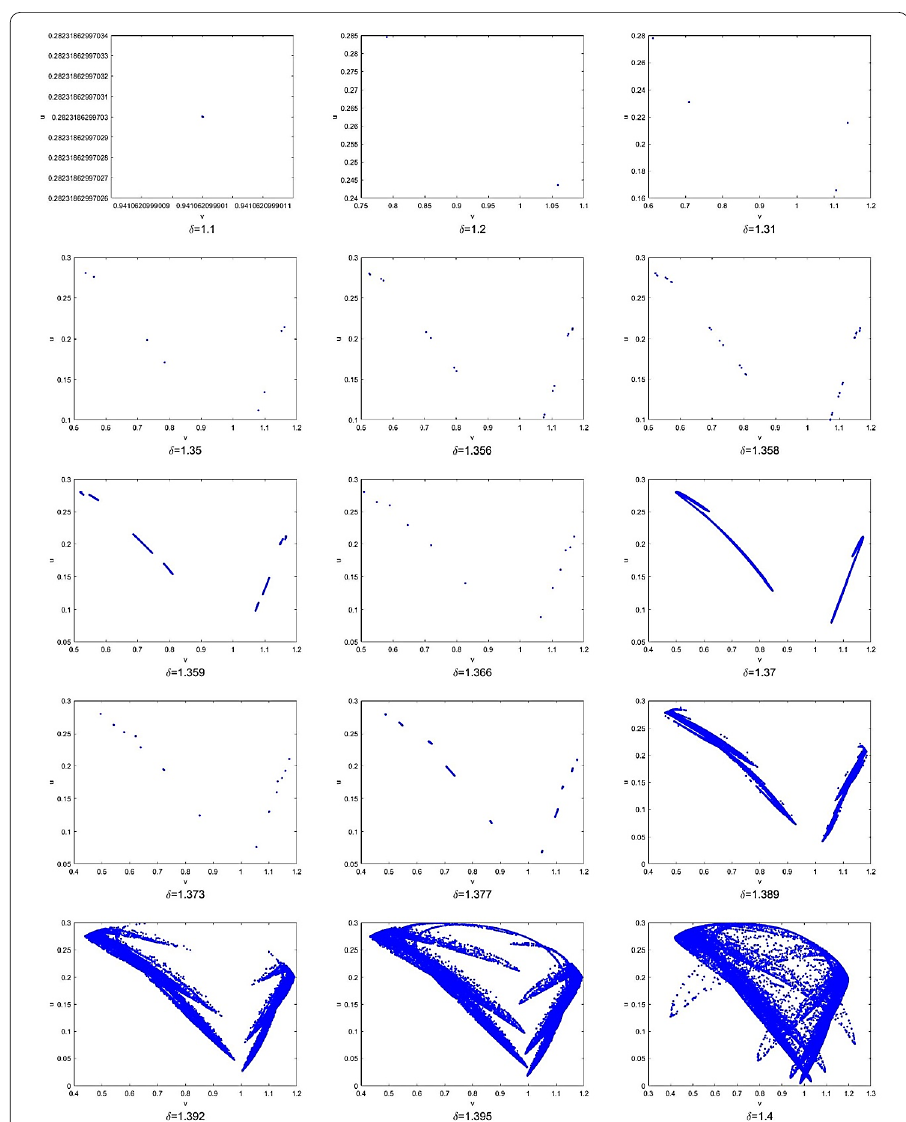
Figure 2 Phase portraits for various values of δ corresponding to Figs. 1(a), (b)